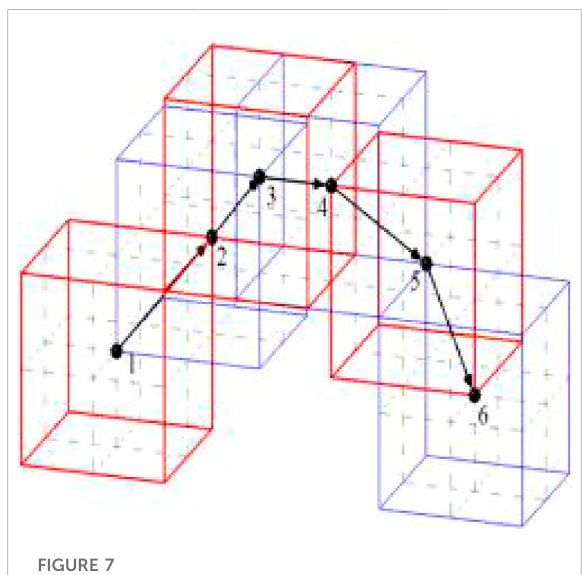
FIGURE 7 Schematic diagram of three-dimensional iterative process.